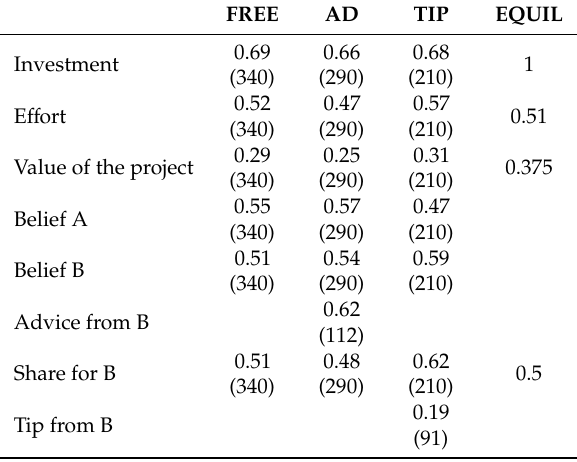
Table 1. Descriptive summaries for the choices in the influence game by